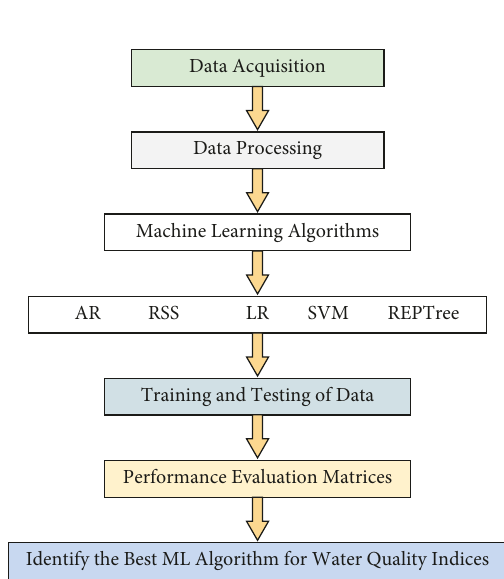
Figure 2: Flowchart of the developed methodology.